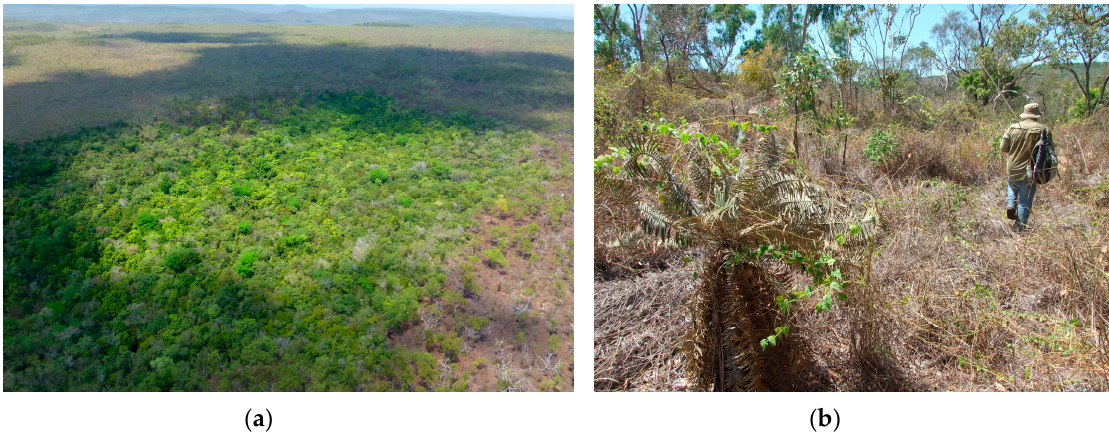
Figure 8. ( a ) A rainforest patch in a fire protected gully surrounded by open savanna on the plateau of the Bougainville Peninsula, and ( b ) a cycad growing amidst senescent long unburnt grass and invasive Stinking Passionflower vines on the Bougainville